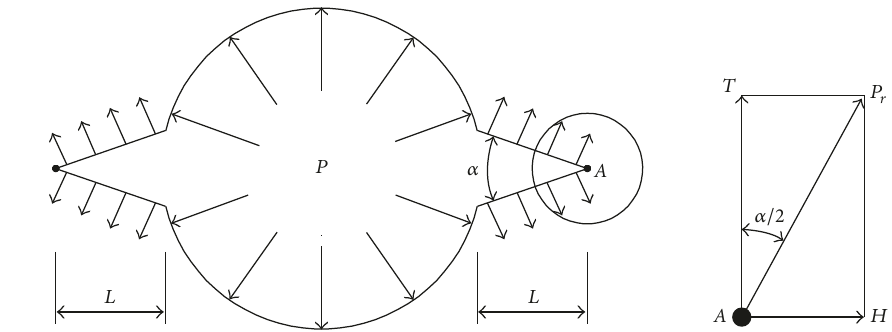
Figure 5: Hole wall of groove hole load distribution.